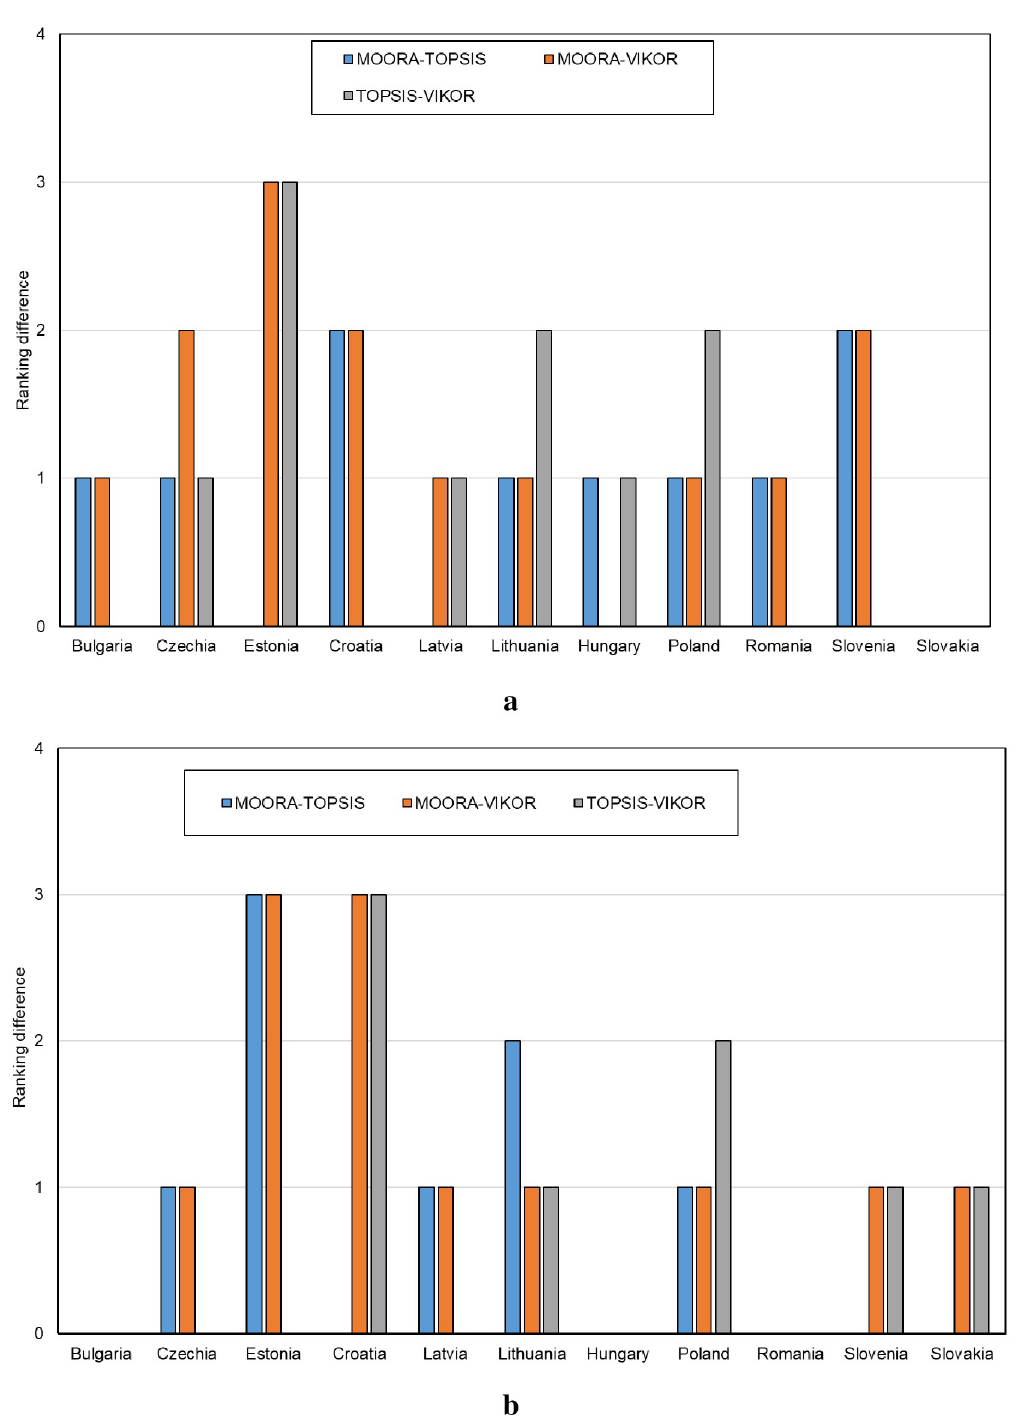
Fig 7. Absolute differences in the rankings between the methods MOORA-TOPSIS, MOORA-VIKOR, TOPSIS-VIKOR (a– all enterprises, b–manufacturing enterprises).